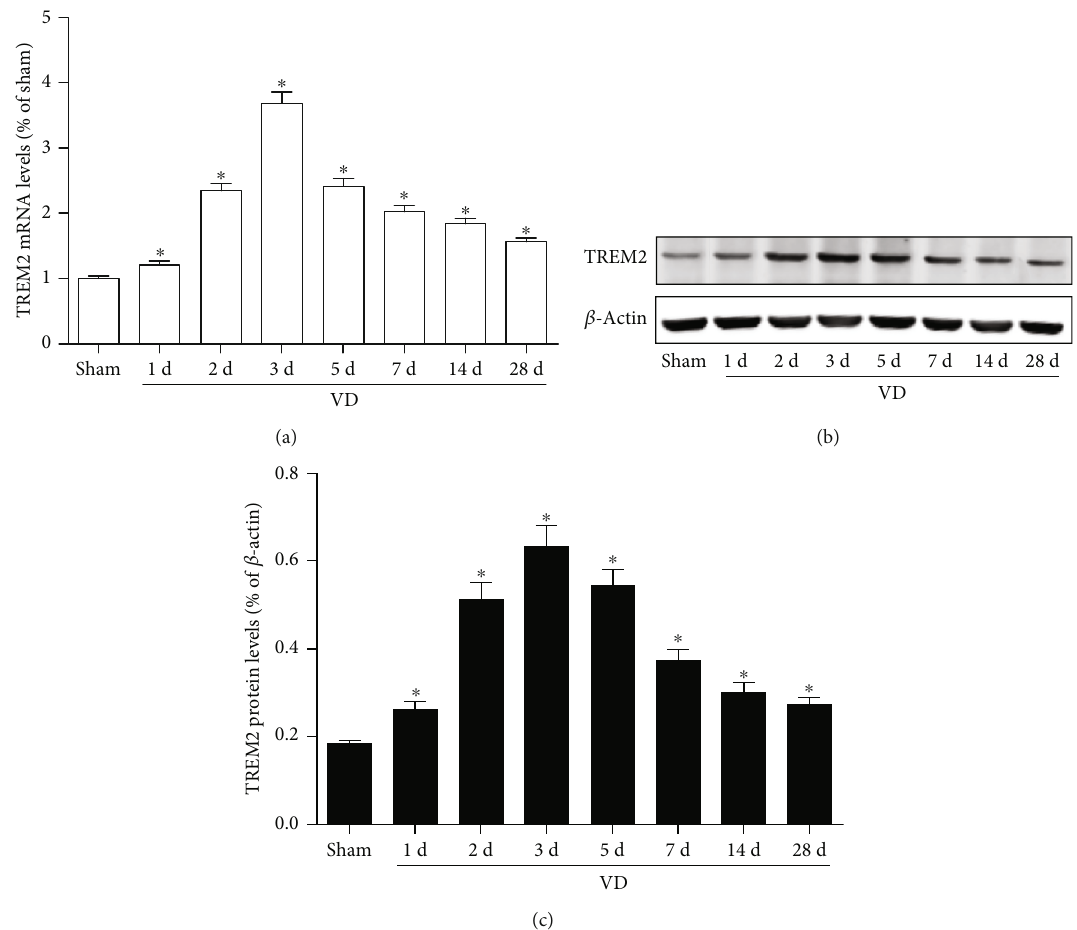
Figure 1: Expression of TREM2 in a mouse model of VD. (a) RT-PCR analysis of TREM2 mRNA level in the hippocampus at di ff erent time points of VD; (b, c) western blot analysis of TREM2 protein level in the hippocampus at di ff erent time points of VD. Compared to the sham group, ∗ p < 0 : 05